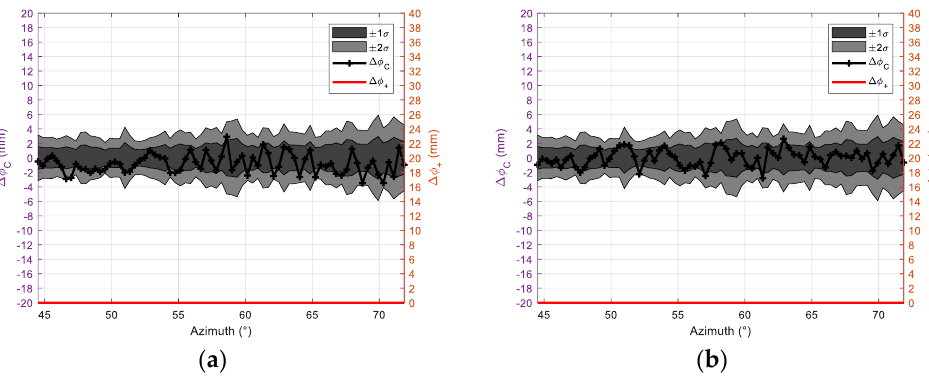
Figure 10. Examples of phase shift from two no-rain days: ( a ) on 15 June 2015; ( b ) on 30 August 2015.